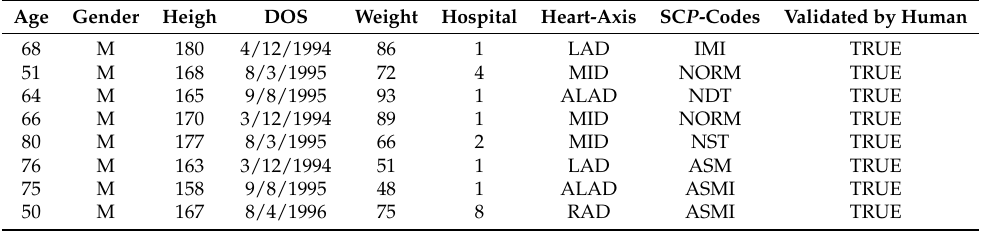
Table 6. Males’ data table.